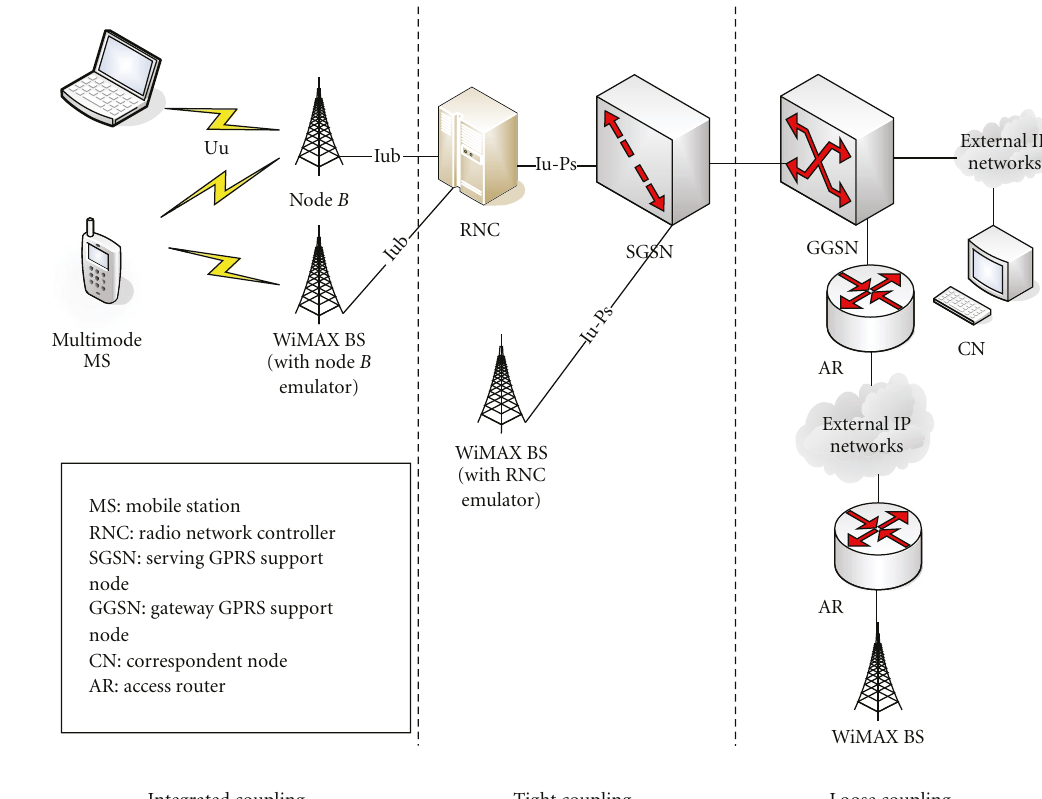
Figure 1: Di ff erent UMTS-WiMAX interworking